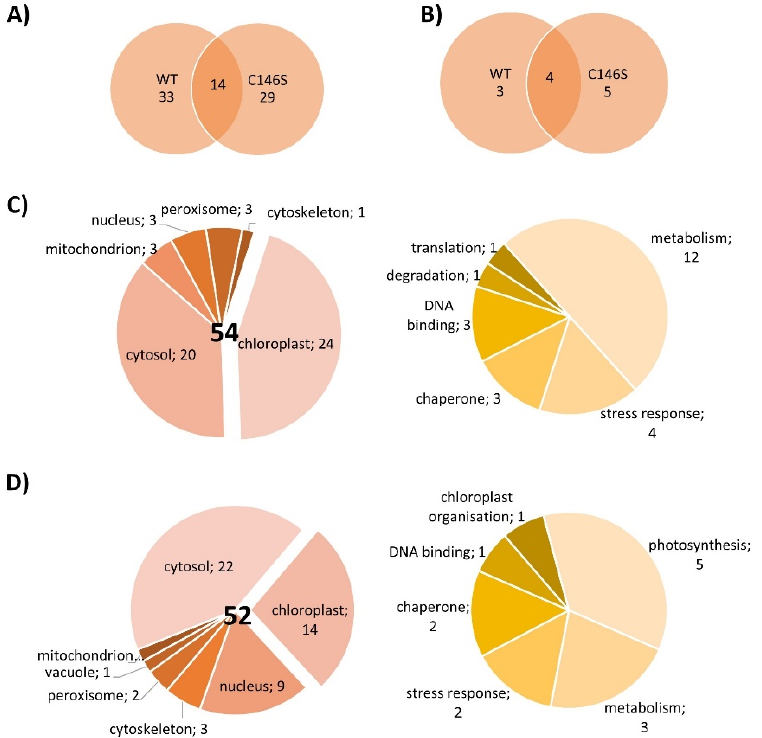
Figure 10. Localization and function of PRX-IIE interaction partners. Venn diagrams depicting unique and overlapping interactors of PRX-IIE WT and C146S variant after ( A ) elution with DTT and ( B ) second elution with imidazole. Identified interacting proteins with ( C ) PRX-IIE WT or ( D ) PRX-IIE C146S during first and second elution, were grouped according to their localization and function. The pie charts on the right hand side in ( C ) and ( D ) reveal the functional assignments of the chloroplast-located proteins. See also supplementary file list of identified proteins.